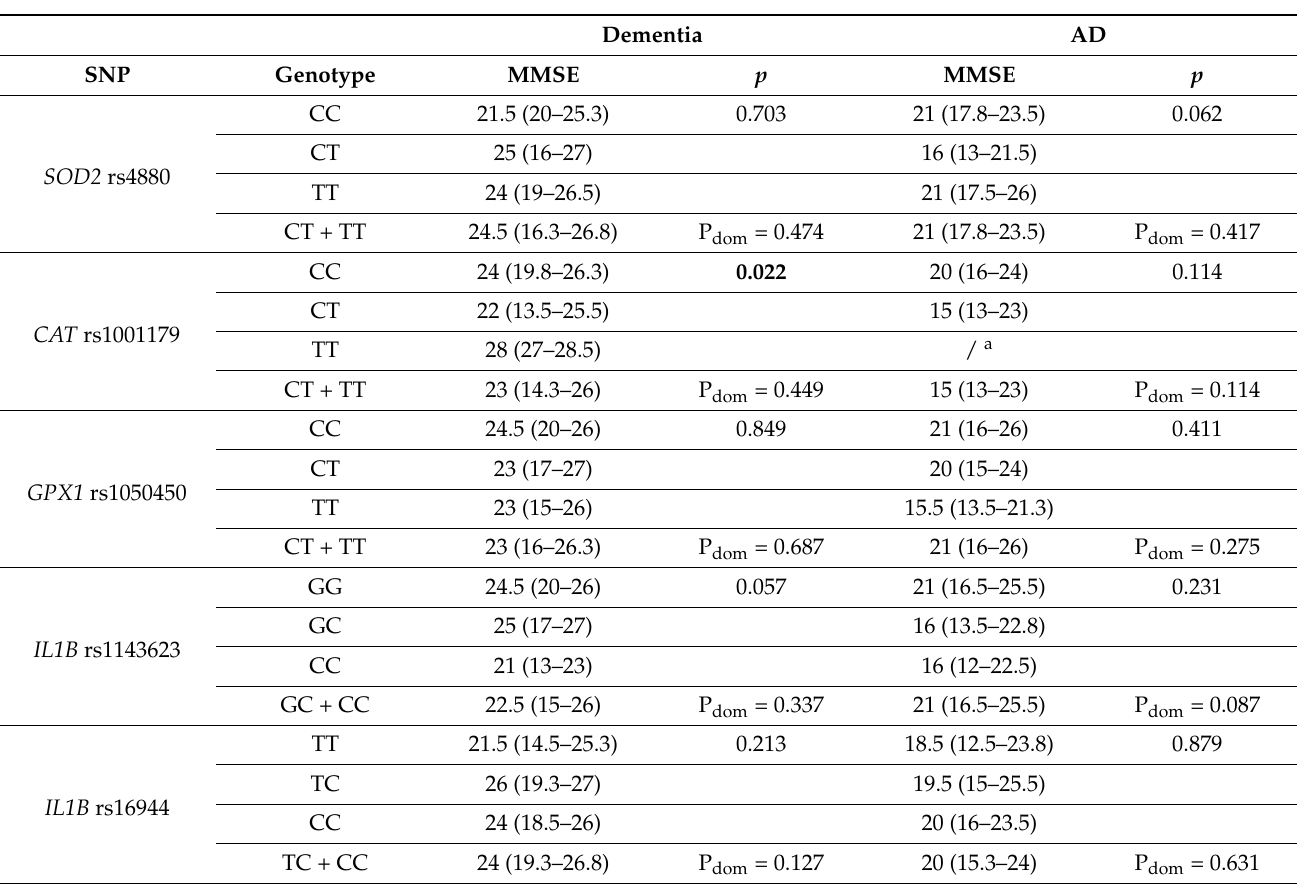
Figure 2. Comparison of the Mini-Mental State Exam (MMSE) scores between different KEAP1 rs1048290 genotypes in: ( a ) whole patient cohort; ( b ) Alzheimer’s disease patients only.